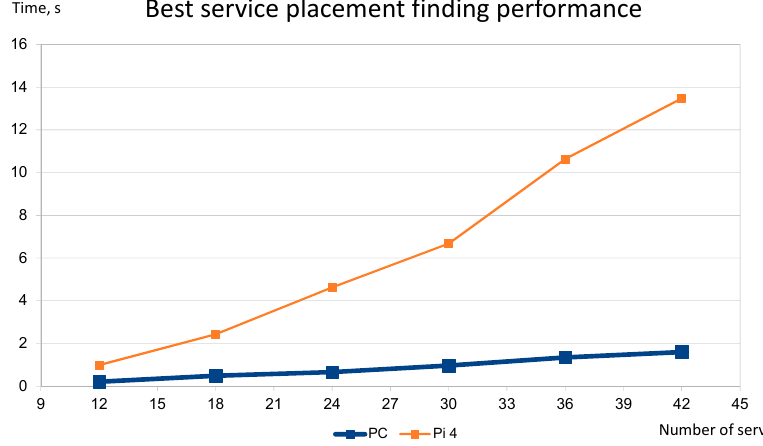
Figure 13. Scalability of the service placement finding algorithm. Table 1. Optimization parameters used for the evaluation of the service placement finding algo- rithm.